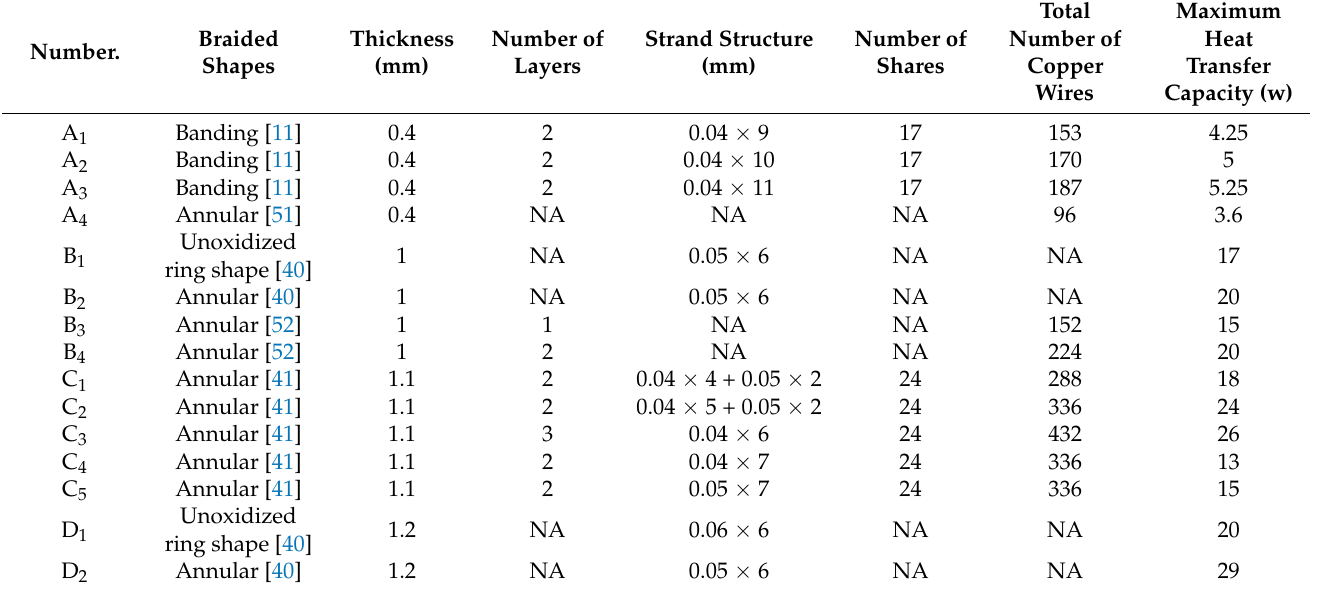
Table 5. Structural parameters and maximum heat transfer capacity of spiral braided mesh wick ultra-thin heat